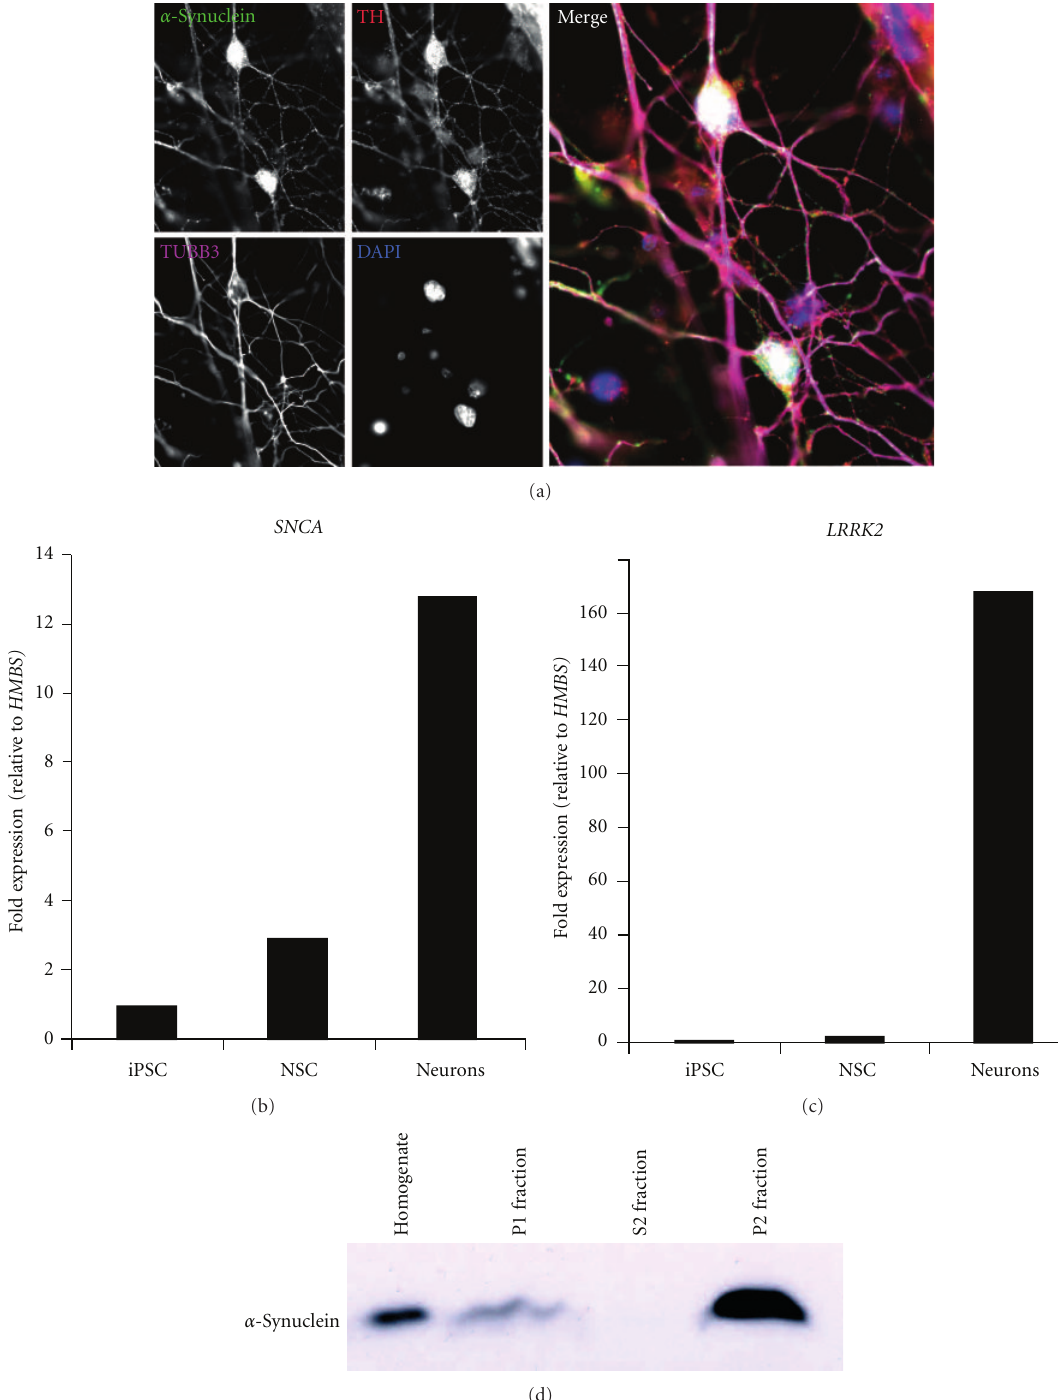
Figure 2: iPS cell-derived neurons express α -synuclein. (a) Immunofluorescence stainings of α -synuclein in TH (tyrosine hydroxylase) and TUBB3 (Tubulin beta-III) positive dopaminergic neurons after 5 months of di ff erentiation show nuclear and vesicular localisation of α - synuclein, (b) and (c) RNA expression of α -synuclein ( SNCA ) and leucine-rich repeat kinase 2 ( LRRK2 ) is upregulated in neurons compared to iPS cells and neural stem cells (NSCs) (normalized to the house-keeping gene HMBS ), and (d) Subcellular fractionation of iPS cell-derived neurons shows nuclear (P1 fraction) and membrane associated, likely synaptic localization (P2 fraction) of α